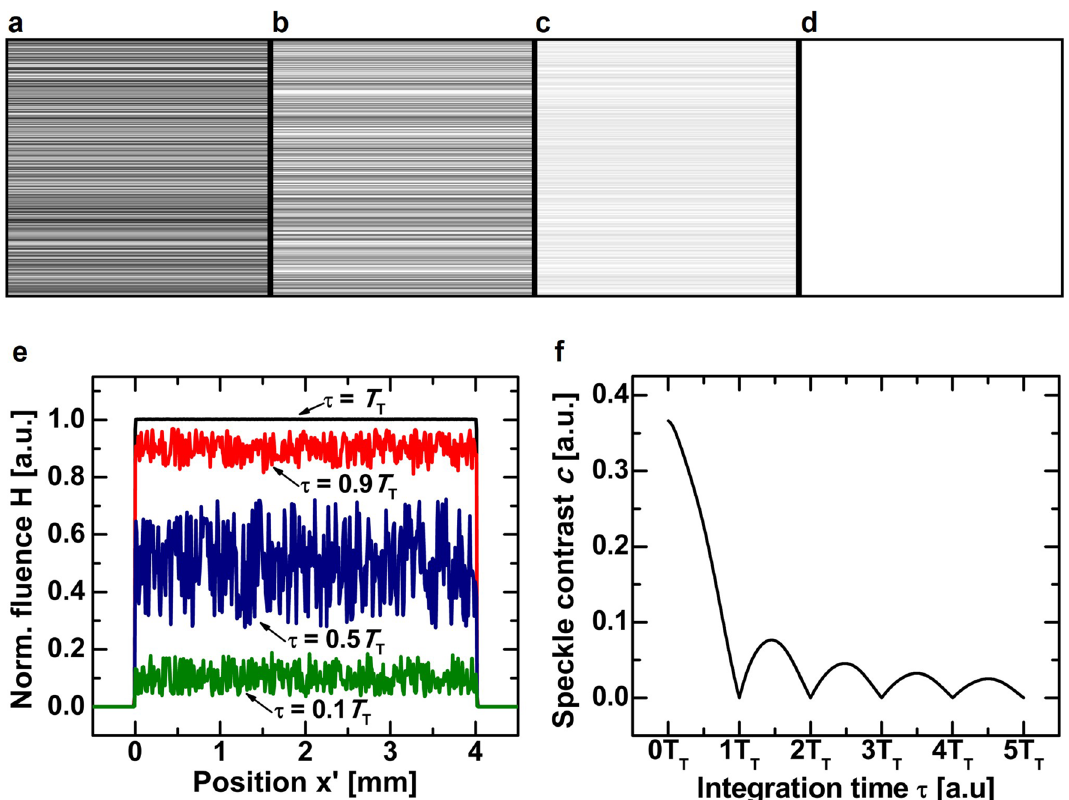
Figure 3. ( a – d ) Simulated reconstruction of a one-dimensional top-hat profile through an AOD for different detector integration times. ( a ) τ = 0.1 T T ; ( b ) τ = 0.5 T T ; ( c ) τ = 0.9 T T ; ( d ) τ = 1 T T . The interference of neighboring image points results in holographic speckle, which is visible as high frequency noise in the observed pattern fluence. The motion of the hologram displayed on the AOD results in a time variant speckle pattern, which when integrated over the characteristic hologram response time T T , averages to zero. ( e ) Cross-section of the simulated top-hat profiles. ( f ) Speckle contrast c of the simulated top-hat profile as function of the detector integration time. The speckle contrast is zero when the integration time is an integer multiple of the response time T T . For longer acquisitions, the contrast reduces step-wise because the fluence of the speckle pattern oscillates while the fluence of the target pattern increases proportional with the integration time τ needs to be an integer multiple of the cosine period for all possible combination of m and n . This is the case when: L T T . (11) τ = v = This time is equal to the characteristic AOD response time T T , which is the duration that a hologram propagat- ing at the speed of the acoustic wave v requires to pass the AOD aperture of length L . During the response time, the AOD performs a complete circular shift of the displayed hologram G , because the driving signal is periodic with the response time, i.e. the hologram matches the size L of the aperture. Therefore, T T is also denoted as hologram cycle time in the further discussion. Figure 3a–d show the simulated reconstruction of a one-dimensional top-hat profile through an AOD for different detector integration times τ. The vertically aligned reconstructions are extended in the horizontal dimension for better visibility. Figure 3e shows the corresponding cross-sections of the reconstructed patterns. We see that the patterns suffer from degradations for small integration times. Over time, these degradations reduce until a perfect top-hat profile is reconstructed by integrating over one complete hologram cycle. Hence, the reconstruction is free of coherent artifacts if the integration time is a multiple of T T . A common quantitative measure for image degradations resulting from coherent artifacts is the speckle contrast c , which is defined by: σ (12) c = I ˆ where σ is the standard deviation of the pattern fluence and Î is its average value. Figure 3f shows the speckle contrast of the simulated top-hat profiles as a function of the integration time over a period of five hologram cycles. The speckle contrast behaves like a damped oscillator, because the fluence of the target pattern H P increases proportional to the integration time, while the amplitude of the coherent sum H S oscillates periodically with T T .